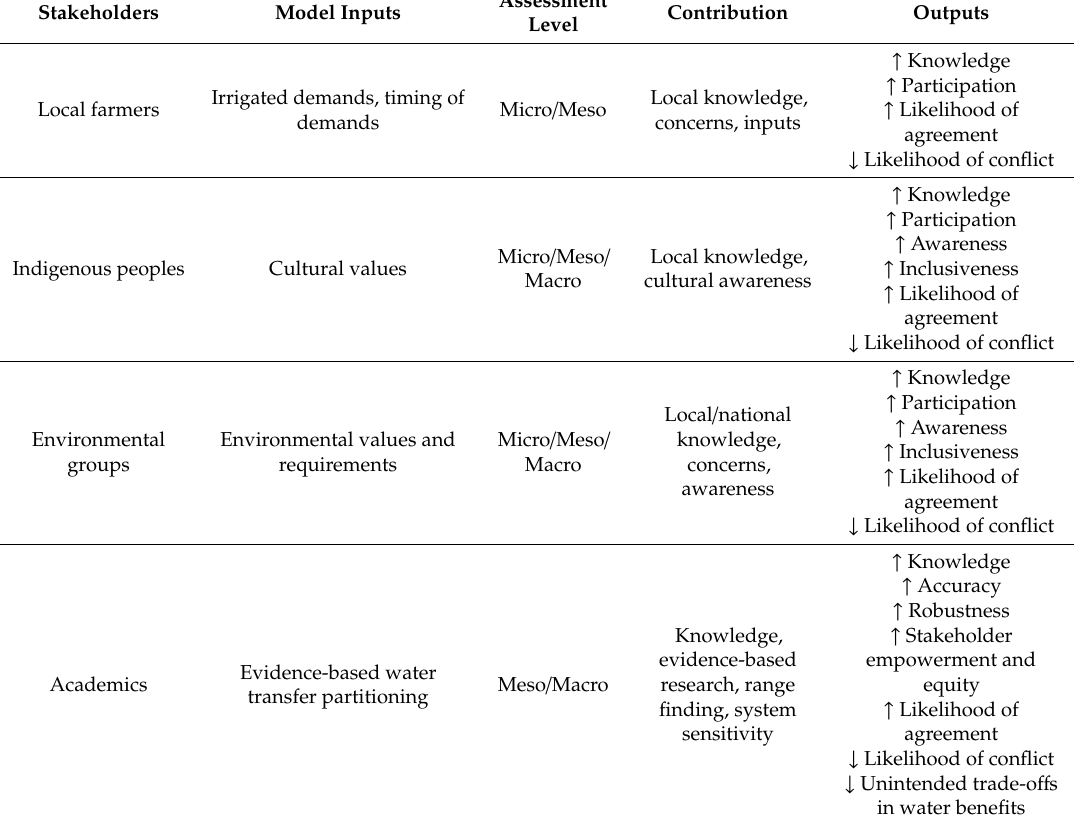
Table 2. Stakeholder model inputs, contributions and outputs at various assessment levels within the Mahanadi Basin. Directions of arrows indicate increases ( ↑ ) and decreases ( ↓ ) of